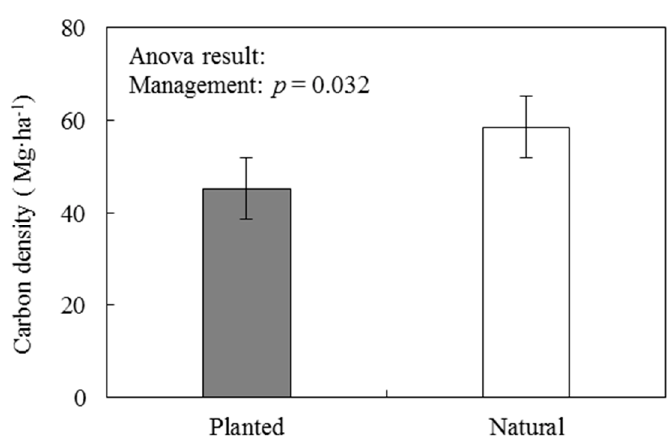
Figure 3. Vegetation carbon density (including tree, understory vegetation and litter layers) of natural and planted Pinus massoniana forests in the Jiangxi Province.